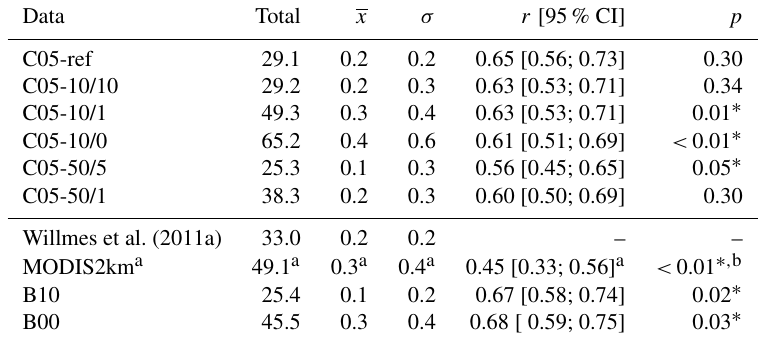
Table 4. Total sea-ice production (IP) (km 3 ) in the winter period 2007/2008, aggregated over polynyas within the four polynya masks (Fig. 2). The daily mean ( x ) and standard deviation ( σ ) are given in km 3 day − 1 . The Pearson correlation coefficient ( r ) was calculated with the IP time series and the estimates of Willmes et al. (2011a). The 95% confidence interval (CI) of r was calculated based on the Fisher z transformation. The critical value is r c ,α = 0 . 05 ,n = 182 = 0.15 and r is significant if r >r c . Two-sided t tests ( α = 5%) were performed and the resulting p values ( p ) are given. Significant differences are marked with ∗ . The results from Bauer et al. (2013) assumed an ice thickness of 10cm (B10) or open water (B00) within polynyas, both without a tile approach.